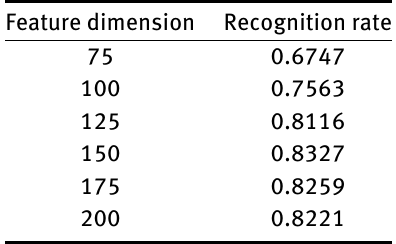
Table 4: Relationship between Feature Dimension of Sparse Representation and Recognition